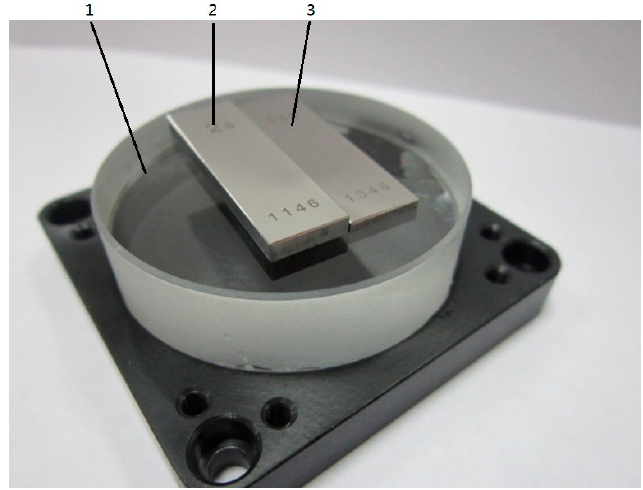
Figure 9. Step height measurement schematic diagram between two gauge blocks. 1: Optical flat; 2: Calibrated gauge block 1; 3: Calibrated gauge 2.